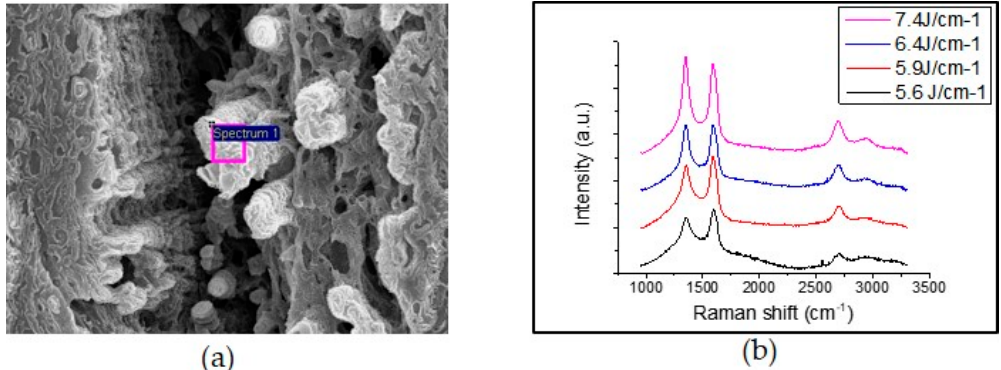
Figure 4. Laser fluence-dependent SEM images of LIG pattern; laser fluence of ( a ) 5.6 J/cm 2 ; ( b ) 5.9 J/cm 2 ; ( c ) 6.4 J/cm 2 ; ( d ) 7.4 J/cm 2 .